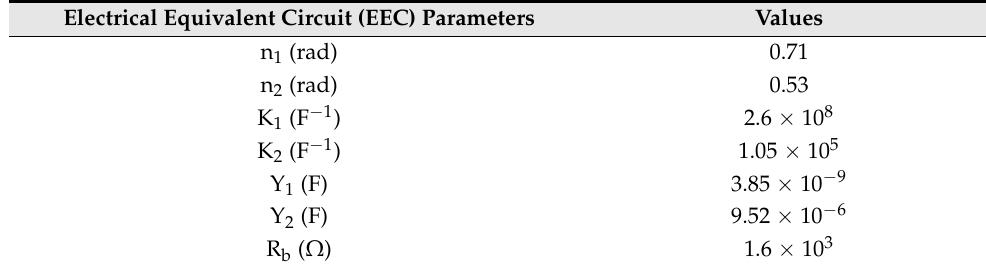
Figure 4. Electrical impedance plot and equivalent circuit diagram (inset) of the prepared polymer electrolyte. Table 1. Various parameters of the circuit elements for the prepared polymer electrolyte system. Electrical Equivalent Circuit (EEC)